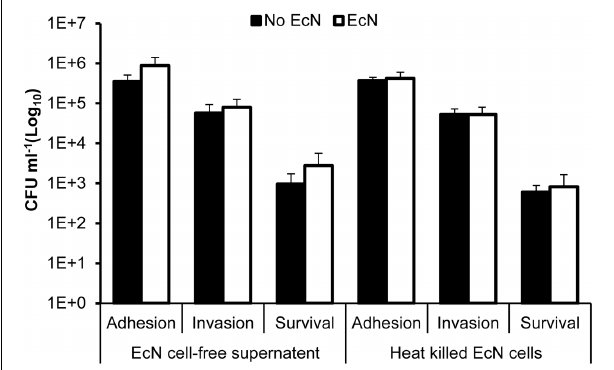
FIGURE 2 | Campylobacter jejuni ’s adhesion to, invasion of and intracellular survival in HT-29 cells pretreated with EcN free supernatant and heat killed cells for 4 h. Heat-killed EcN were generated by heating exponentially growing cultures to 65 ◦ C for 5 min and checking the loss of viability by culturing on LB agar plates. EcN-free supernatant was prepared from exponentially growing cultures, which were centrifuged and filtered through a sterile membrane. The experiments were repeated at least two times and samples were processed in four replicates in each